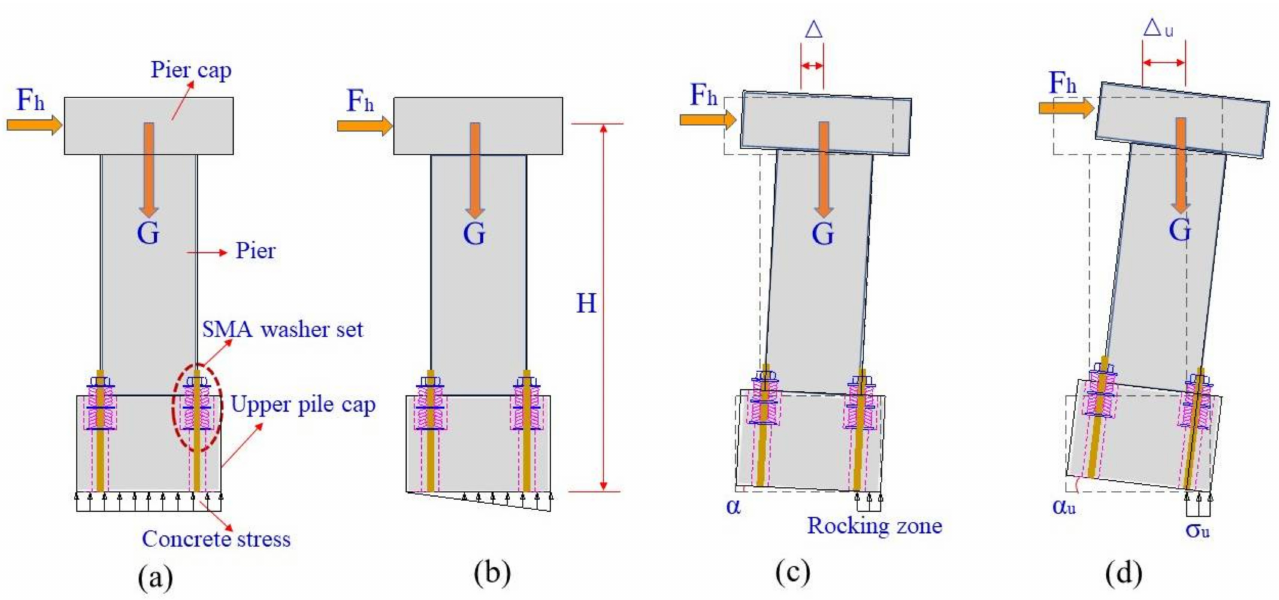
Figure 2. Rocking mechanism of the SMA washer-based pier. ( a ) Original state; ( b ) Onset of uplift; ( c ) Rocking state; ( d ) Self-locking